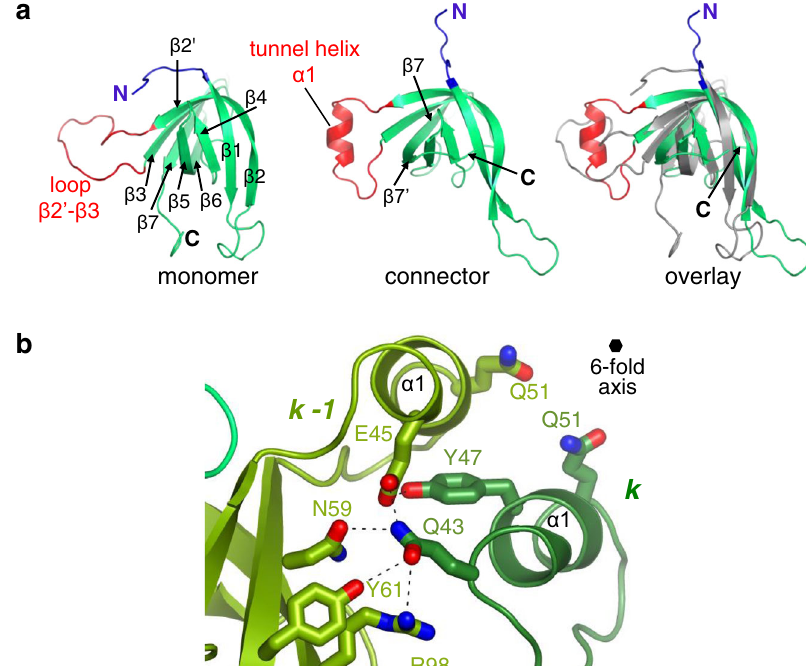
Fig. 4 | Conformational changes of gp16. a Comparison of the NMR structure of theassembly-naïvegp16monomer(leftpanel,PDB2KCA)withonesubunitofgp16 in the connector (central panel). The N-terminus is shown in dark blue (residues 1 – 7)andloop β 2 ’ - β 3isinred(residues40 – 56).Therightpanelshowstheoverlayof